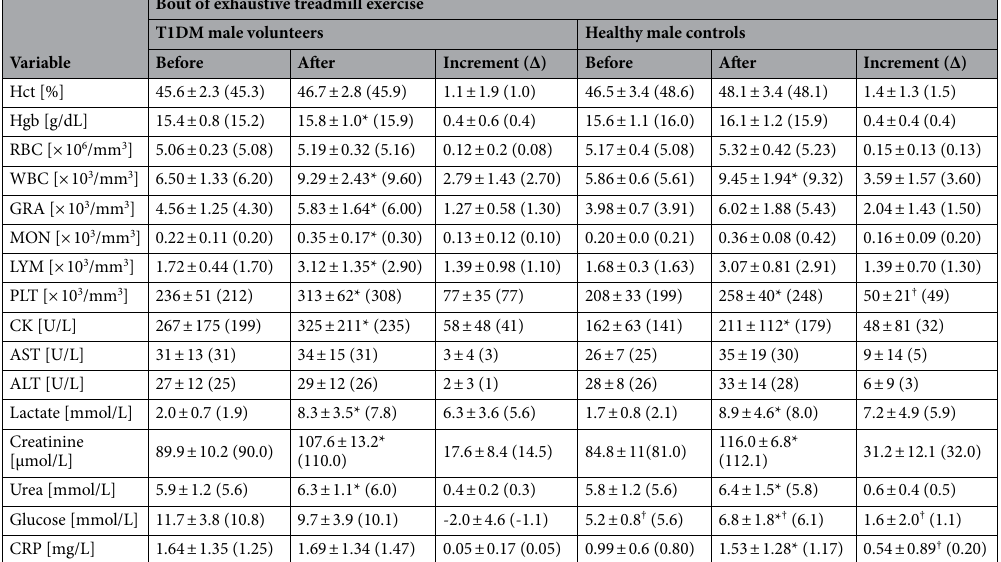
Table 3. Changes of blood cell count, selected circulating markers of muscle damage and metabolic response to exercise in average-trained males with TIDM and healthy controls after exhaustive treadmill run. T1DM type 1 diabetes mellitus, Hct hematocrit, Hgb hemoglobin, RBC red blood cells, WBC white blood cells, GRA granulocytes, MON monocytes, LYM lymphocytes, PLT platelets, CK creatine kinase, AST asparate aminotransferase, ALT alanine aminotransferase, CRP-C reactive protein. Results are expressed as mean ± standard deviation and (median in parentheses). Other details as for Table 2. *– vs corresponding value before the bout, p < 0.05. † – vs corresponding value in T1DM group, p < 0.05.